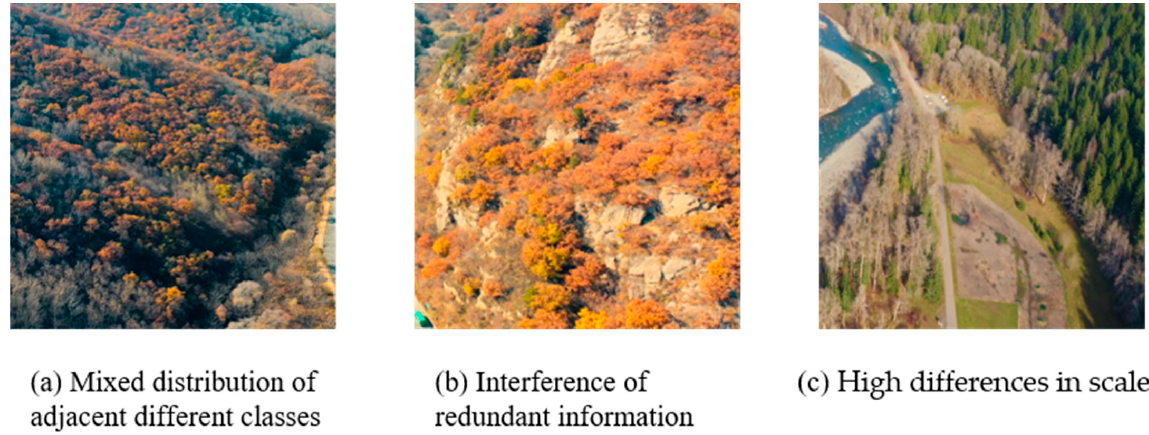
Figure 1. Showcase of partial forest remote sensing images in the datasets.